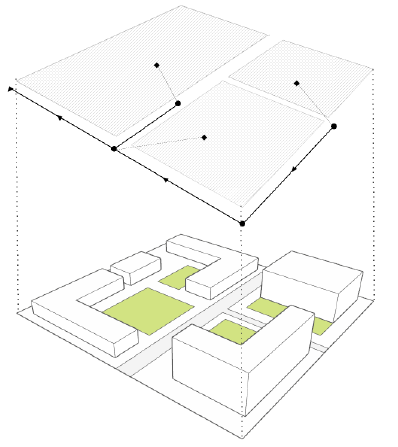
Figure 3. Schematic diagram of SWMM 1D output extracted from site space